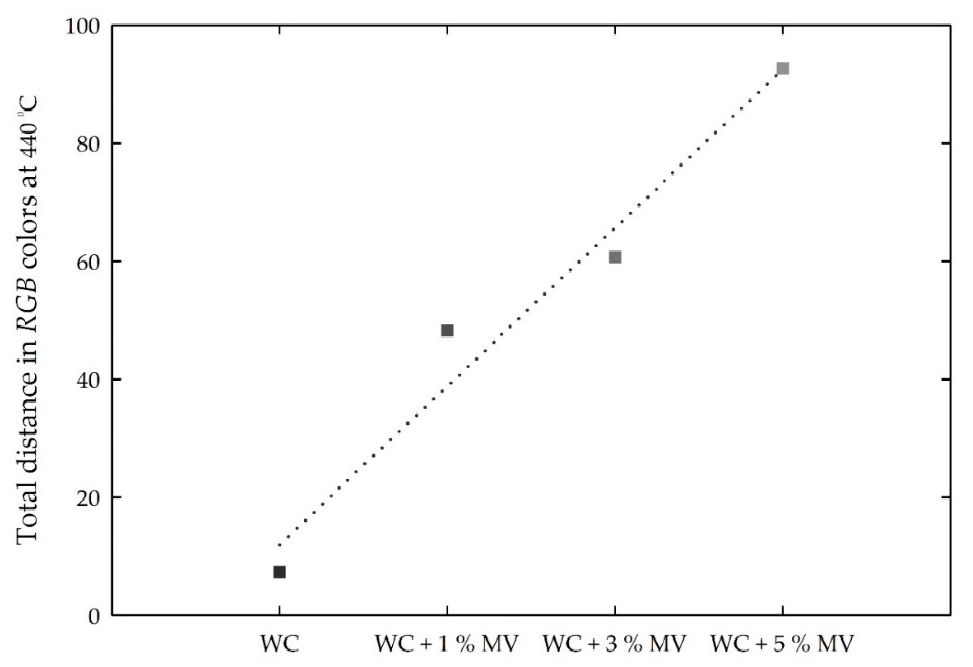
Figure 11. Changes in the RGB values for the white cement (WC) mixed samples with increasing MV pigment contents at 440 ◦ C.